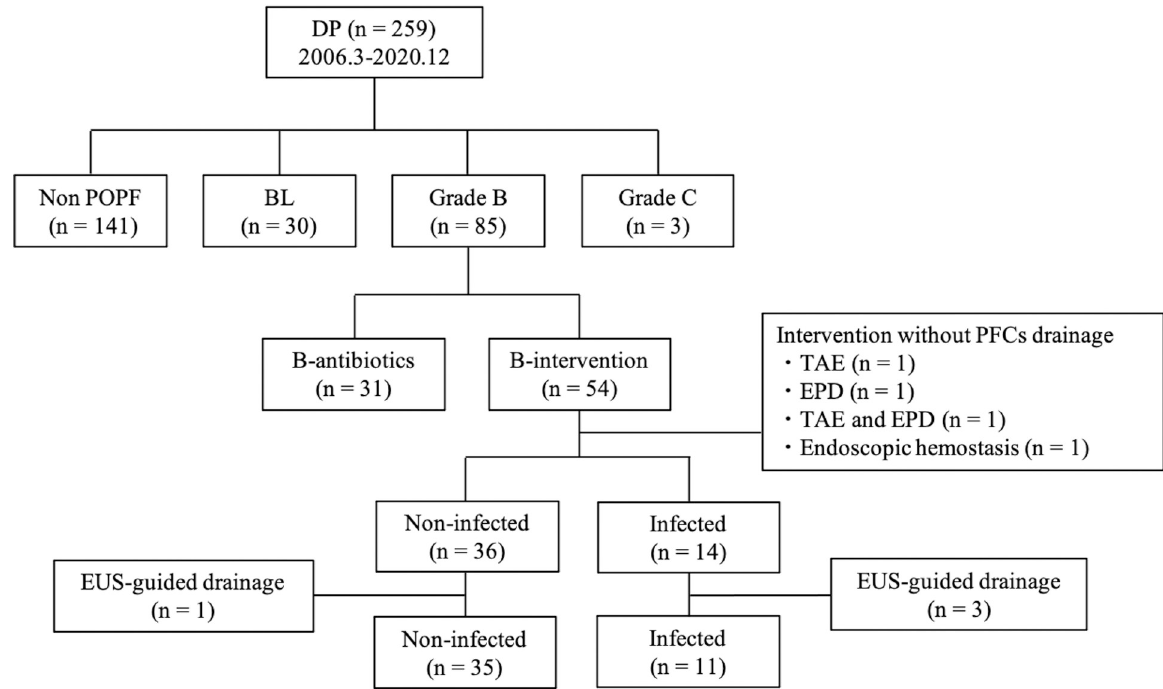
Fig 2. Flowchart of the subclassification of grade B POPF. DP: distal pancreatectomy, POPF: postoperative pancreatic fistula, BL: biochemical leak, PFCs: peripancreatic fluid collections, TAE: transcatheter arterial embolization, EPD: endoscopic pancreatic drainage, EUS: endoscopic